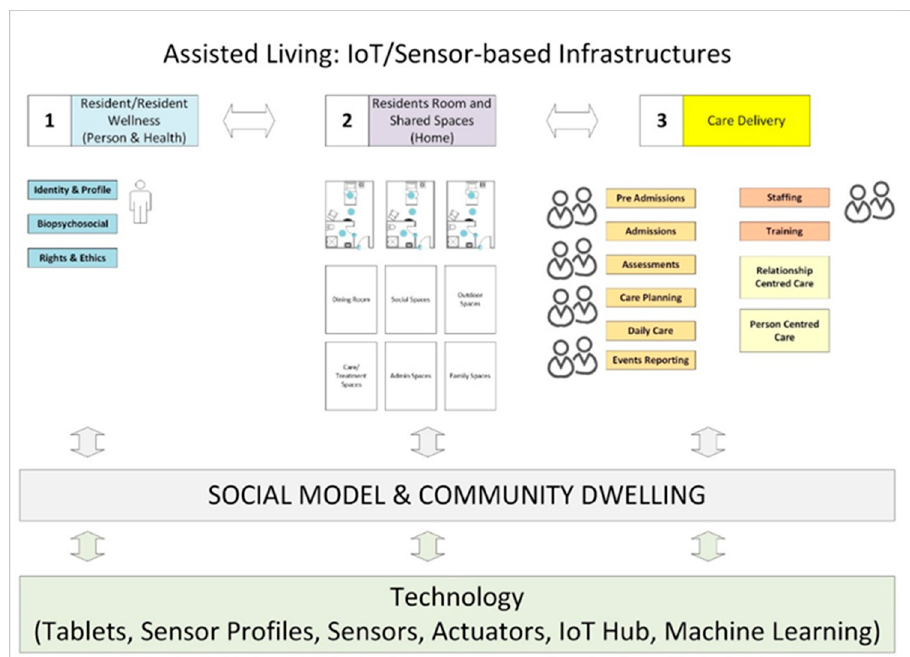
Figure 12. Internet of Things (IoT)/Sensor based infrastructures and 3 structuring principles.